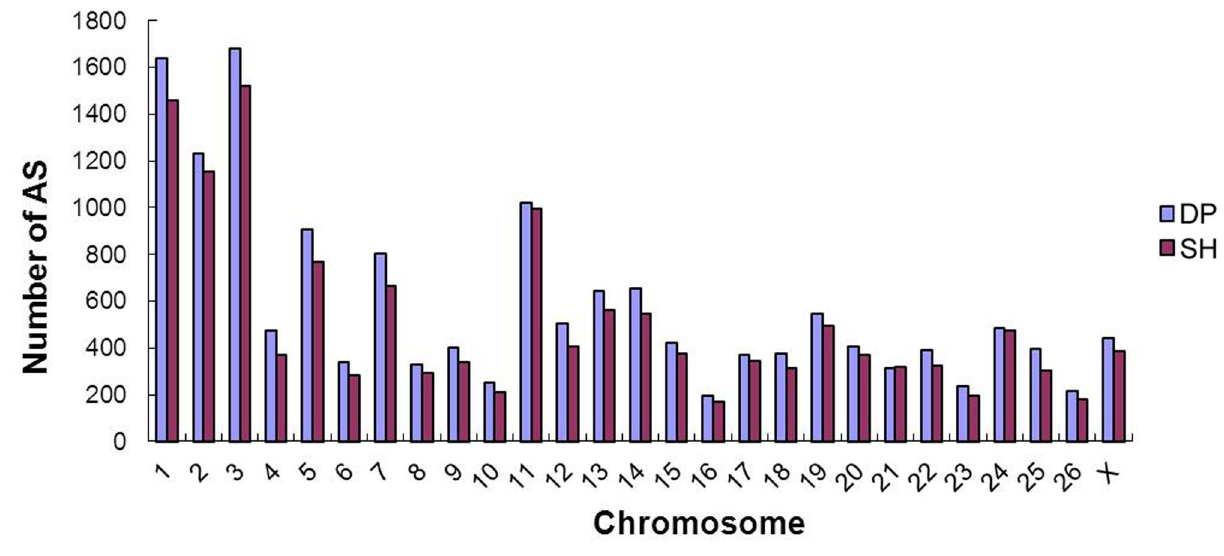
Figure 8. Alternative splicing events on every chromosome. The distribution of the 29,511 putative AS events detected in the two samples on the 26 autosomes and the X allosome of the sheep are shown. All of the AS distributed primarily on chromosomes 1, 2 and